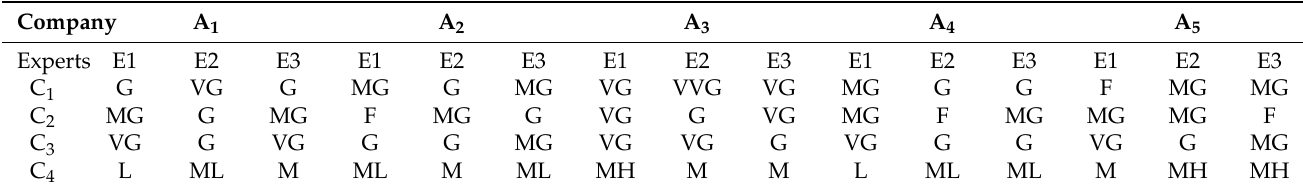
Table 6. Linguistic assessments of company provided by the three experts.